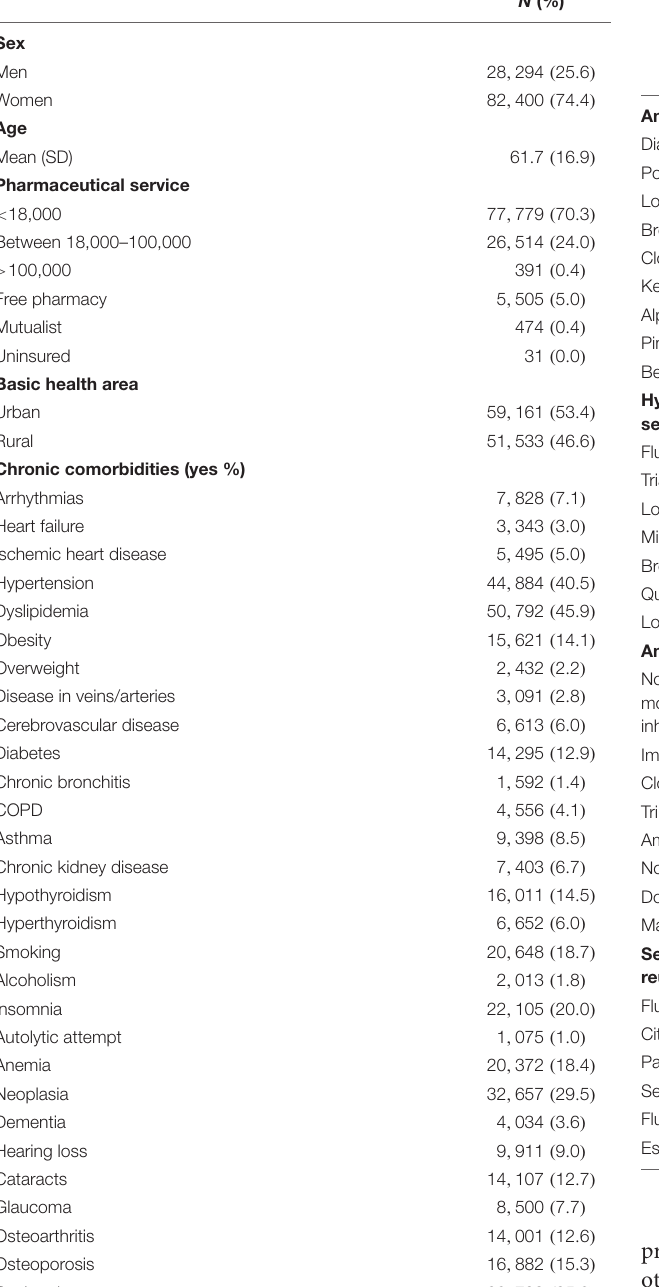
TABLE 2 | Number of DHD 6 months before and 6 months after N (%)